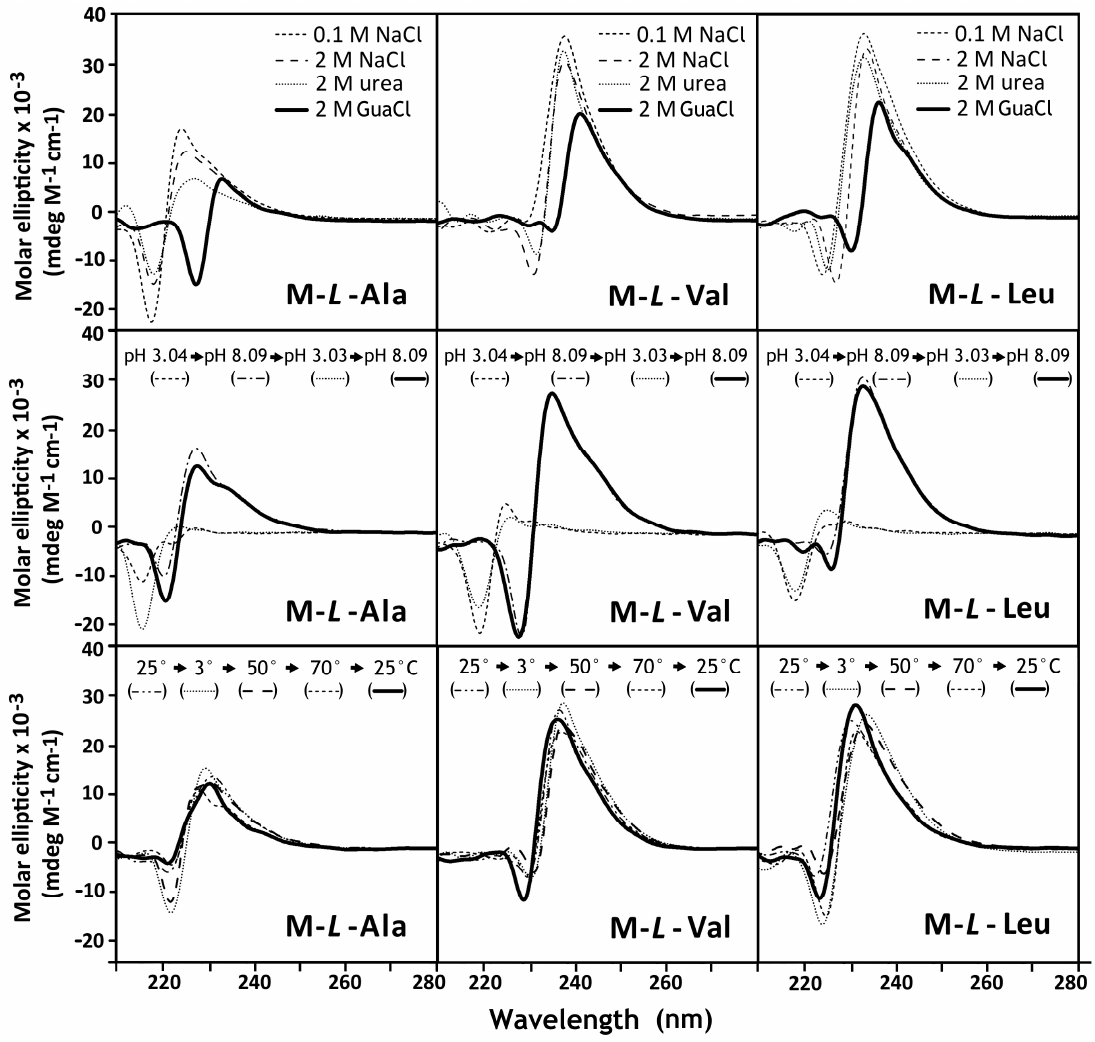
Figure 5. Dependence of PAAC CD spectra on a change of: ionic strength and presence of denaturating agents, namely urea and guanidinium chloride (GuaCl) (upper row); pH (intermediate row); temperature (bottom row). Operational conditions: 1.83 ± 0.17 mM repeating units and, where not otherwise stated, in 0.1 M NaCl solution.